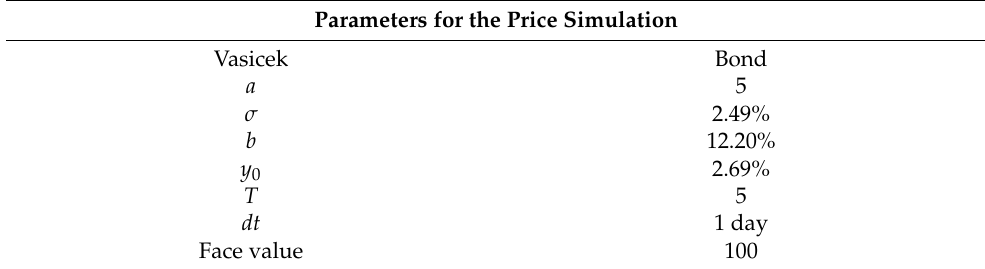
Table 2. The parameters of the price simulation in case of the bonds. Parameters for the Price